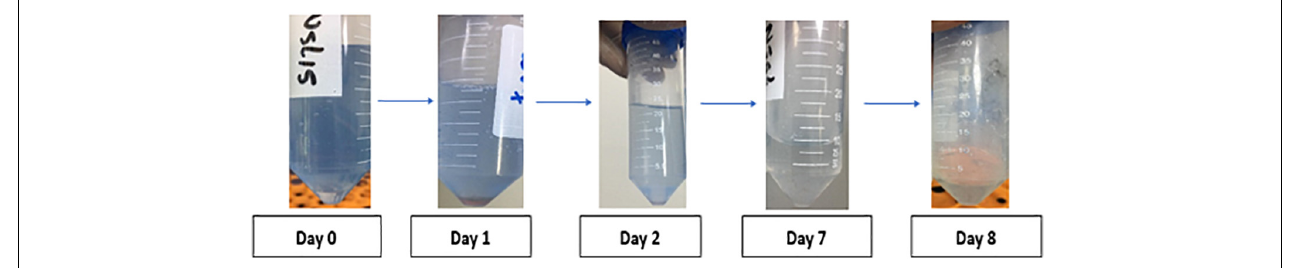
FIGURE 3 | DCPIP assay of a representative smoker sample showing dye discoloration. during anthracene biodegradation over a period of 8 days in a representative smoker sample.